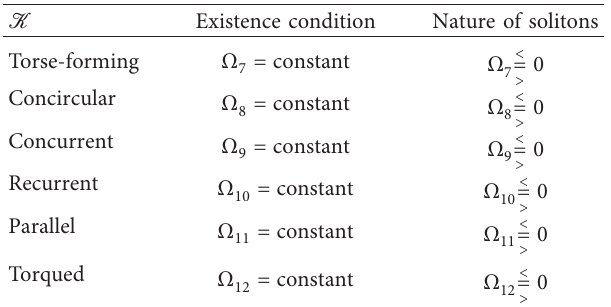
Table 5: Relationship between K , existence condition, and nature of solitons.